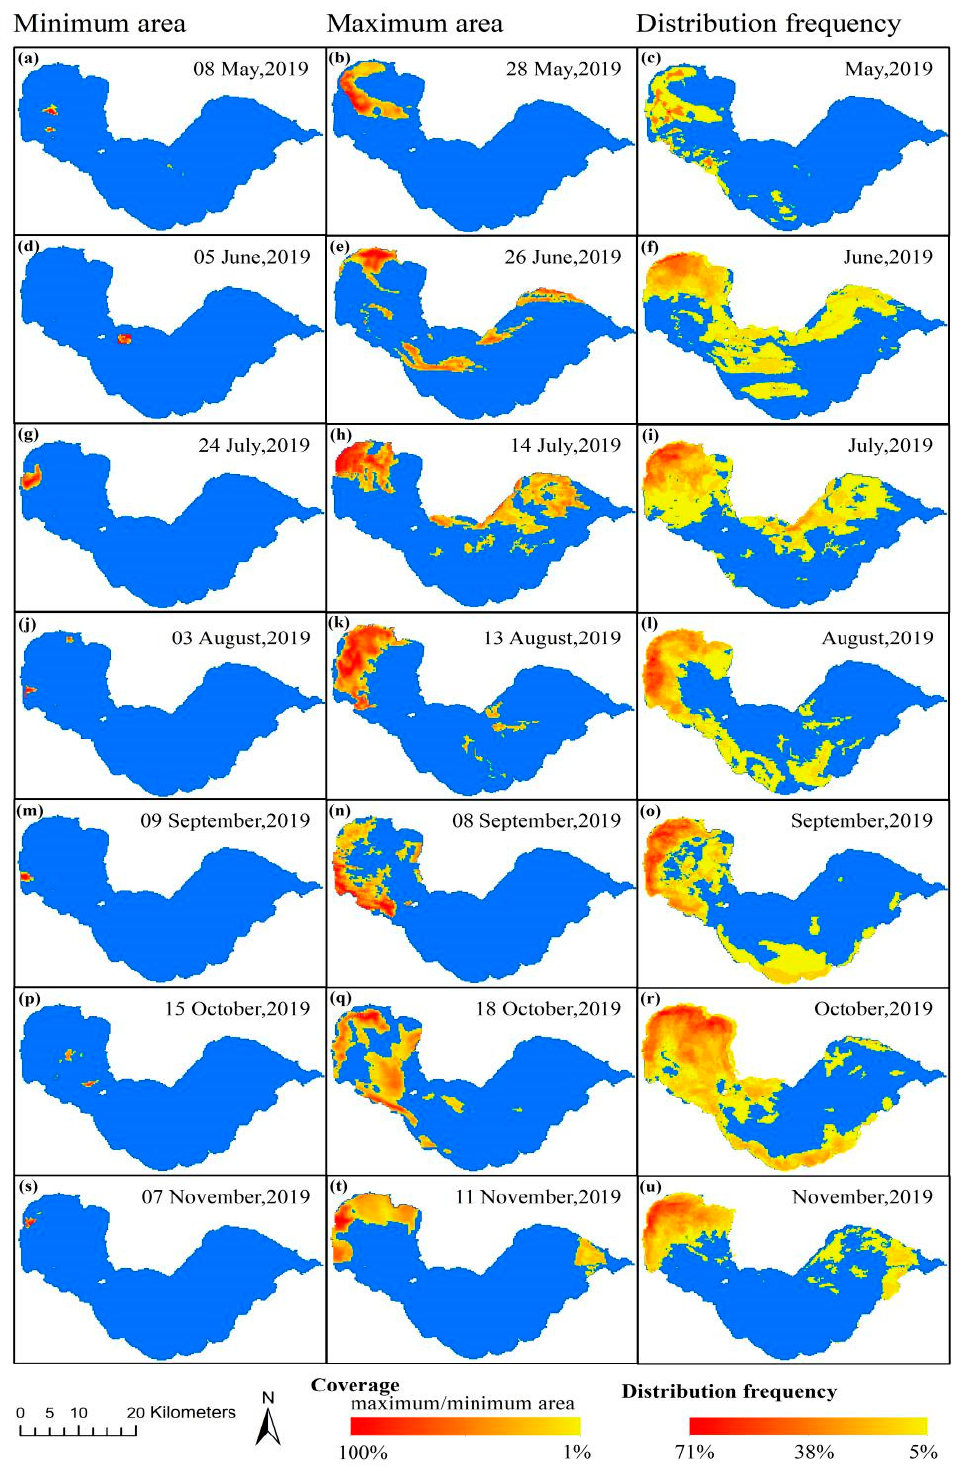
Figure 9. Spatial distribution of the minimum area, the maximum area, and the frequency of the monthly HAB in Chaohu Lake: ( a , d , g , j , m , p , s ) The minimum HAB area of each month from May to November, ( b , e , h , k , n , q , t ) The maximum HAB area of each month from May to November, ( c , f , i , l , o , r , u ) The HAB distribution frequency of each month from May to